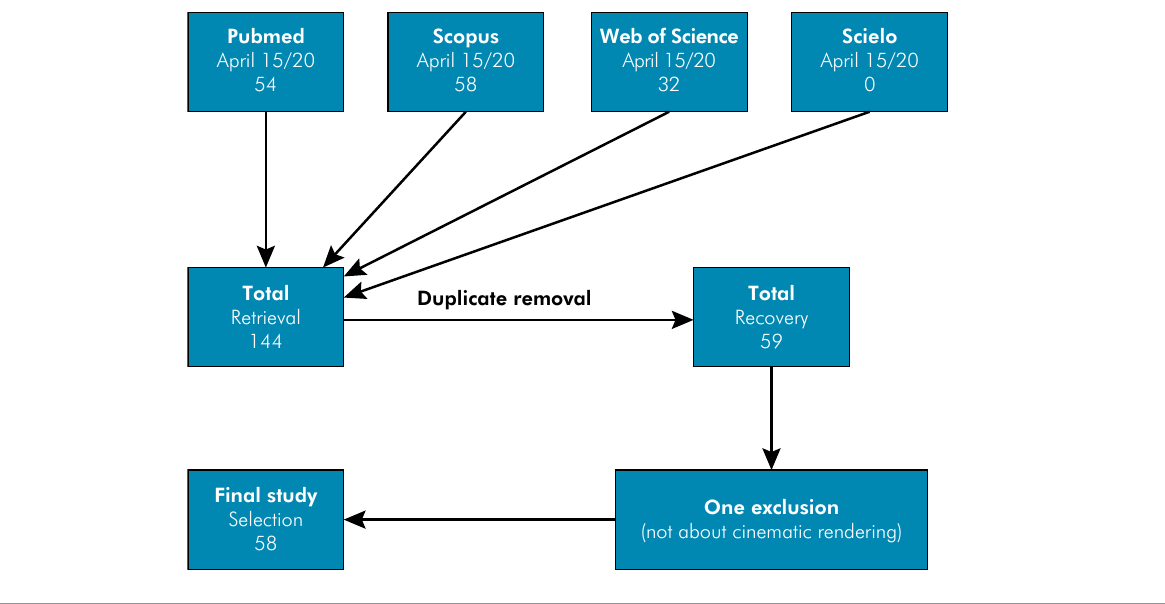
Figure 1. Study selection